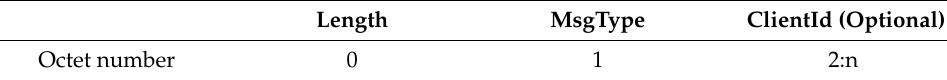
Table 5. Pingreq message